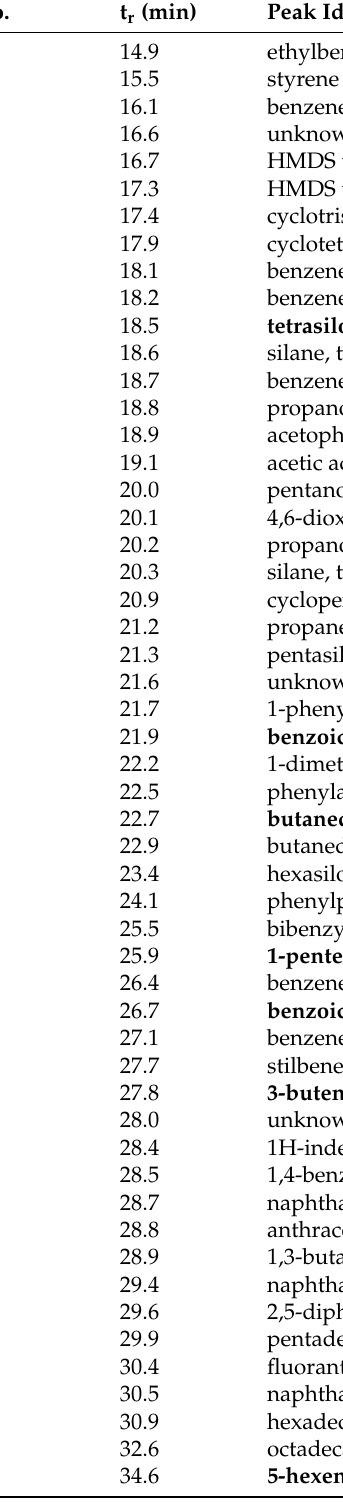
Table 3. Identification of peaks in the chromatogram obtained in the Py(HMDS)–GC–MS analysis of the MeOH extract of PS-4w (Figure 11). Bold: most abundant species in the chromatogram; most abundant ions in the mass sppectra.